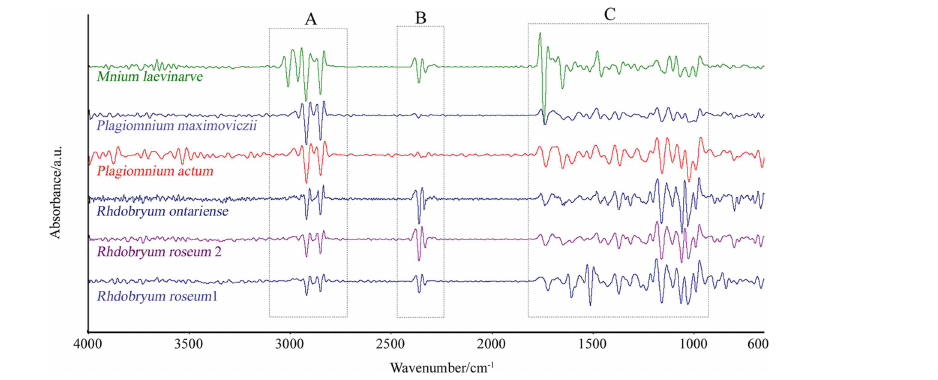
Fig 2. Mean Second-DerivativeSpectra of Six